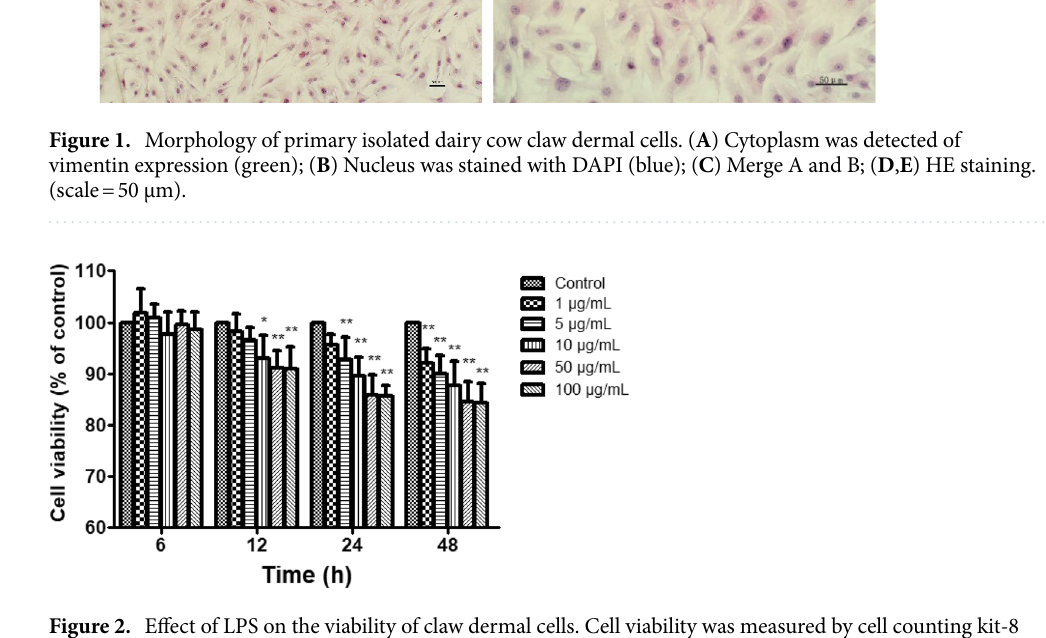
Figure 2. Effect of LPS on the viability of claw dermal cells. Cell viability was measured by cell counting kit-8 (CCK-8) method with the treatment of various concentrations (1, 5, 10, 50, 100 μg/mL) of LPS for 6, 12, 24, 48 h. The data were presented as mean ± SEM (n = 6). * P < 0.05 vs. control group; ** P < 0.01 vs. control group.